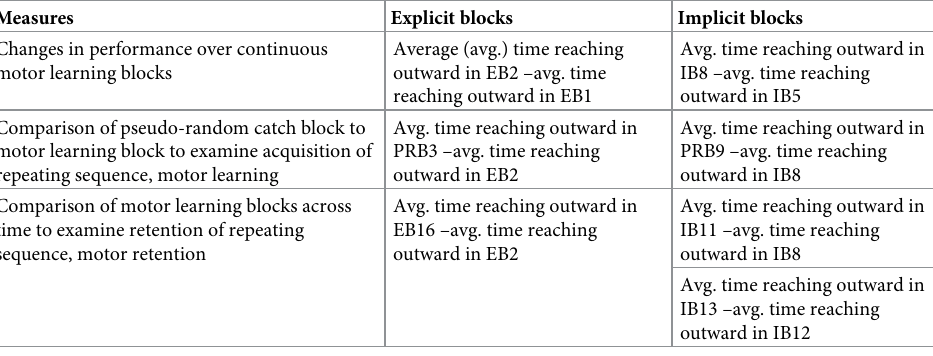
Average (avg.) time reaching Avg. time reaching outward in outward in EB2 –avg. time IB8 –avg. time reaching reaching outward in EB1 outward in IB5